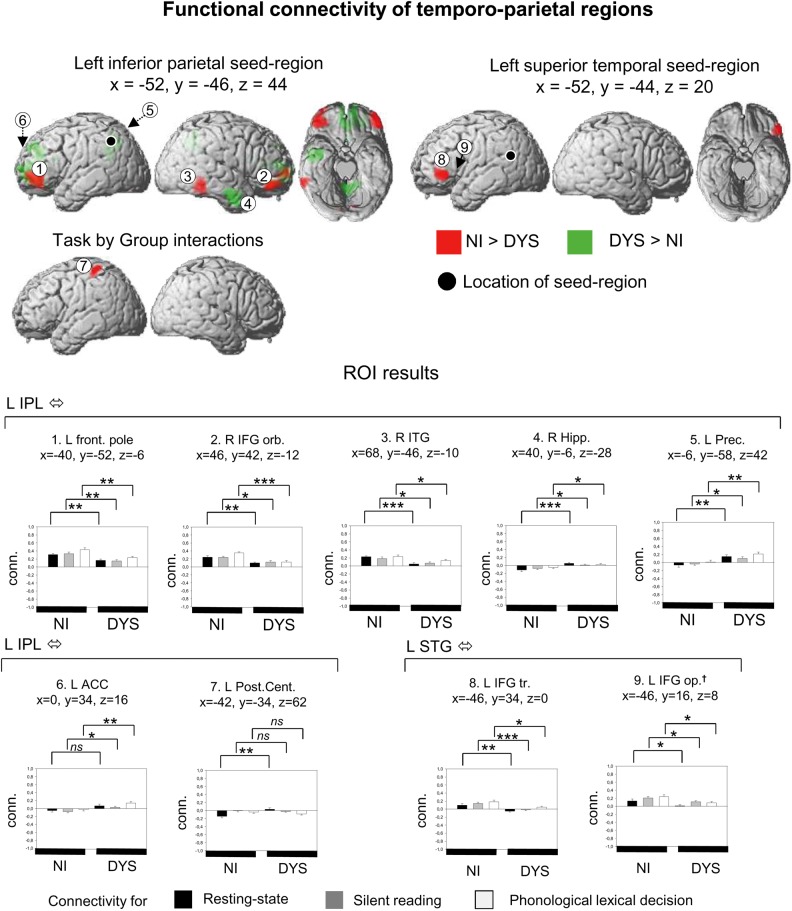
Functional connectivity for seed regions in the left inferior parietal lobule and the left posterior superior temporal gyrus. † area found at an uncorrected threshold of p < 0.001 and 20 voxel extent on the whole-brain level. All other details same as in Figure 2.